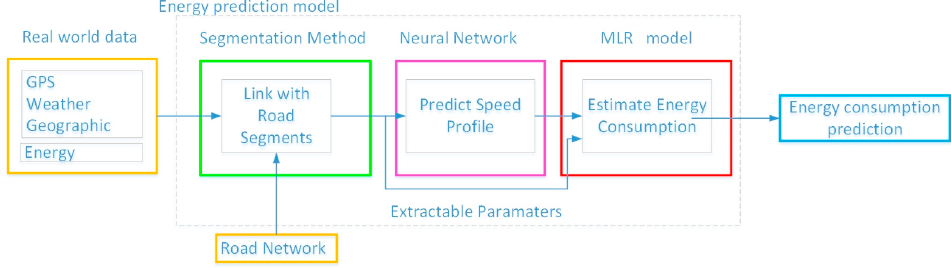
Figure 1. Schematic overview of the proposed energy prediction models and their flow of calculations. MLR: multiple linear regression; GPS: global positioning system. MLR: multiple linear regression; GPS: global positioning